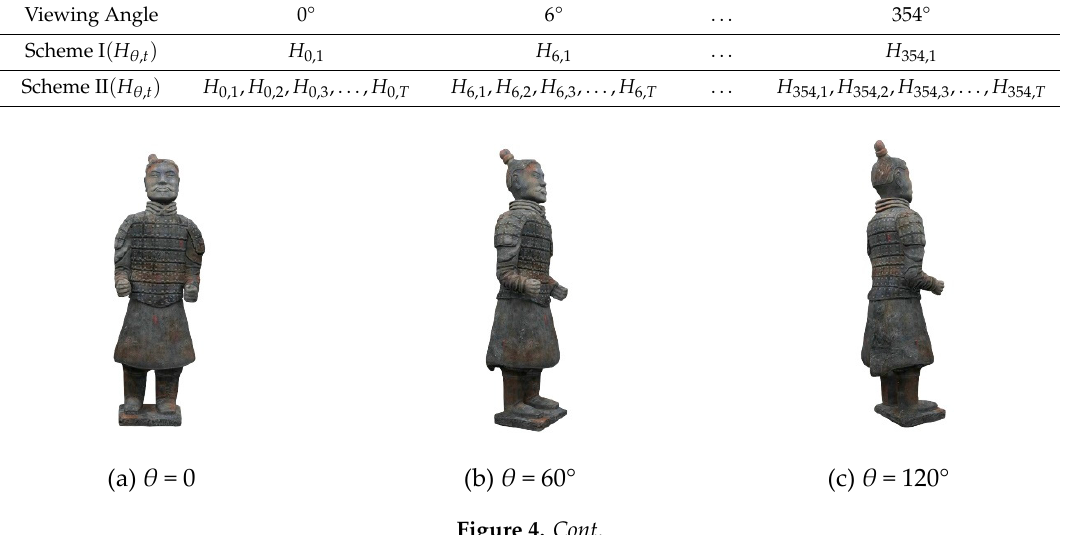
Table 1. Kinoform sequence schemes for dynamic three-dimensional (3D) holographic display. Viewing